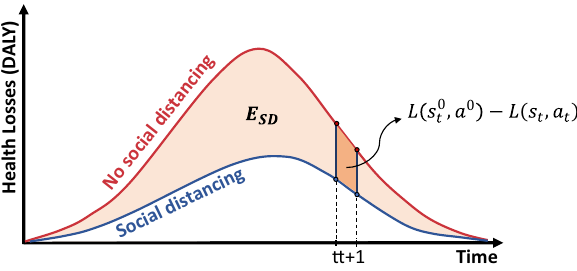
Figure 7. The health effect E SD is shown as the difference between health losses resulting from the null intervention without social distancing (red curve) and health losses averted by a social distancing intervention (blue curve). Period-wise health effect: E SD